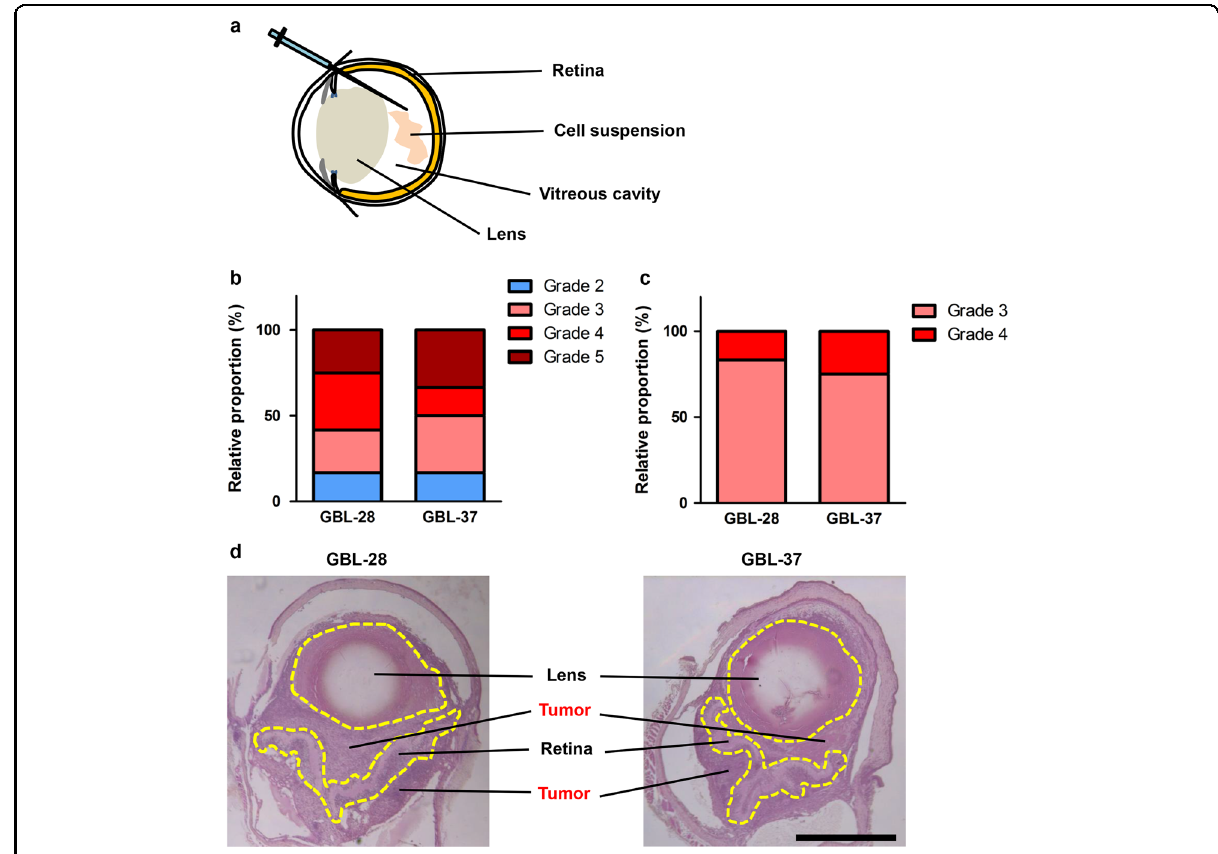
Fig. 3 Development of a novel PDX model of glioblastoma via intravitreal injection. a A schematic diagram demonstrating the intravitreal injection of tumor cells. b The relative proportion of mice with grade 2 – 5 disease after the intravitreal injection of GBL-28 and GBL-37 cells that underwent normal culture conditions. c The relative proportion of mice with grade 3 or 4 disease after the intravitreal injection of GBL-28 and GBL-37 cells that underwent hypoxia treatment for 4 h before injection. d Representative images of H&E-stained sections of the eyeball at 4 weeks after the intravitreal injection of GBL-28 or GBL-37 cells that underwent hypoxia treatment for 4 h before injection. The yellow dashed lines indicate the lens and retina. Scale bar: 1